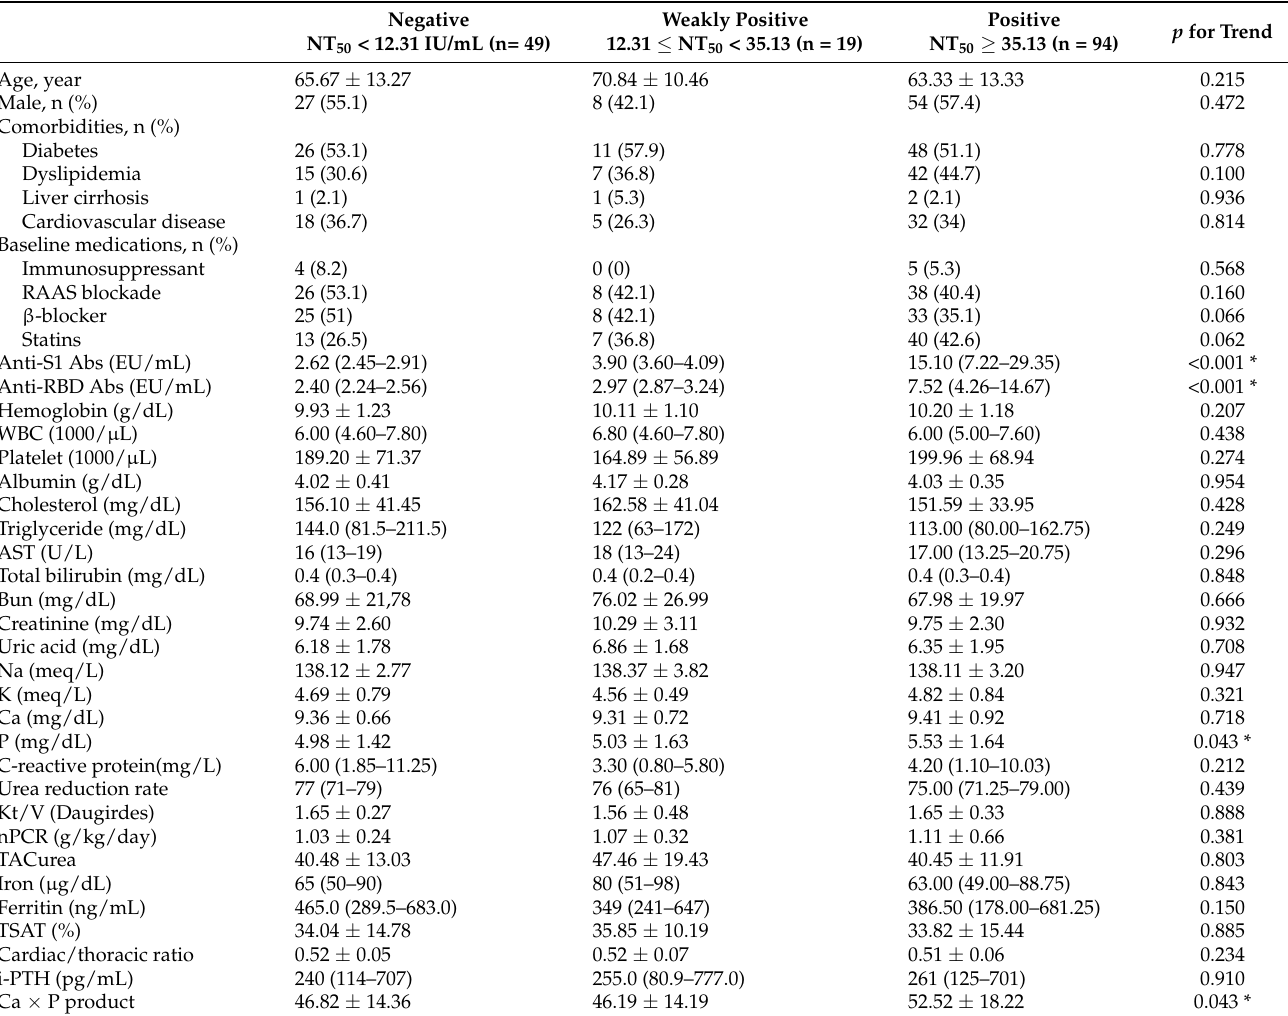
Table 1. Comparison of demographics and clinical characteristics between the groups with various humoral responses after two doses of